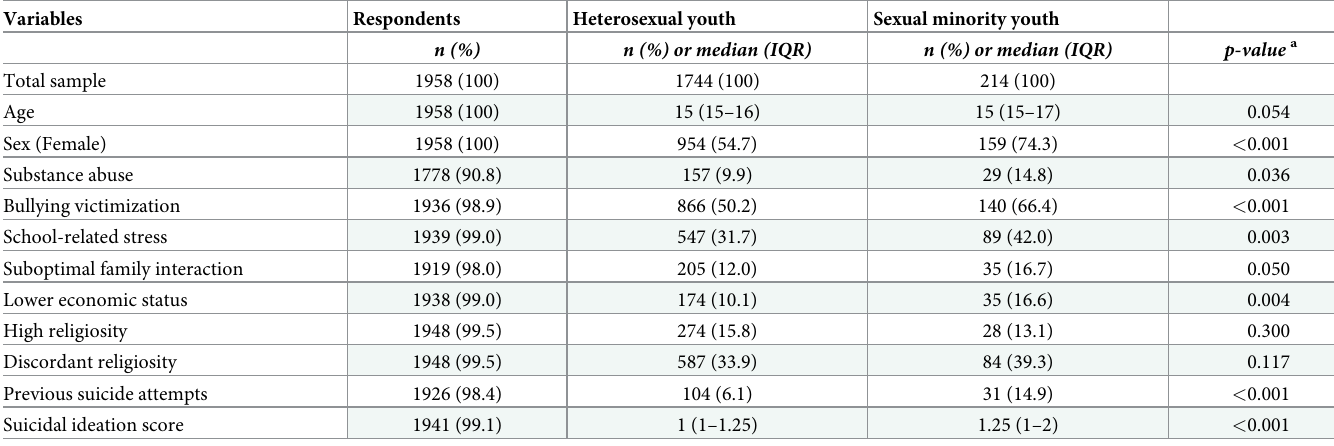
Table 1. Baseline characteristics of the study population in association with sexual orientation.